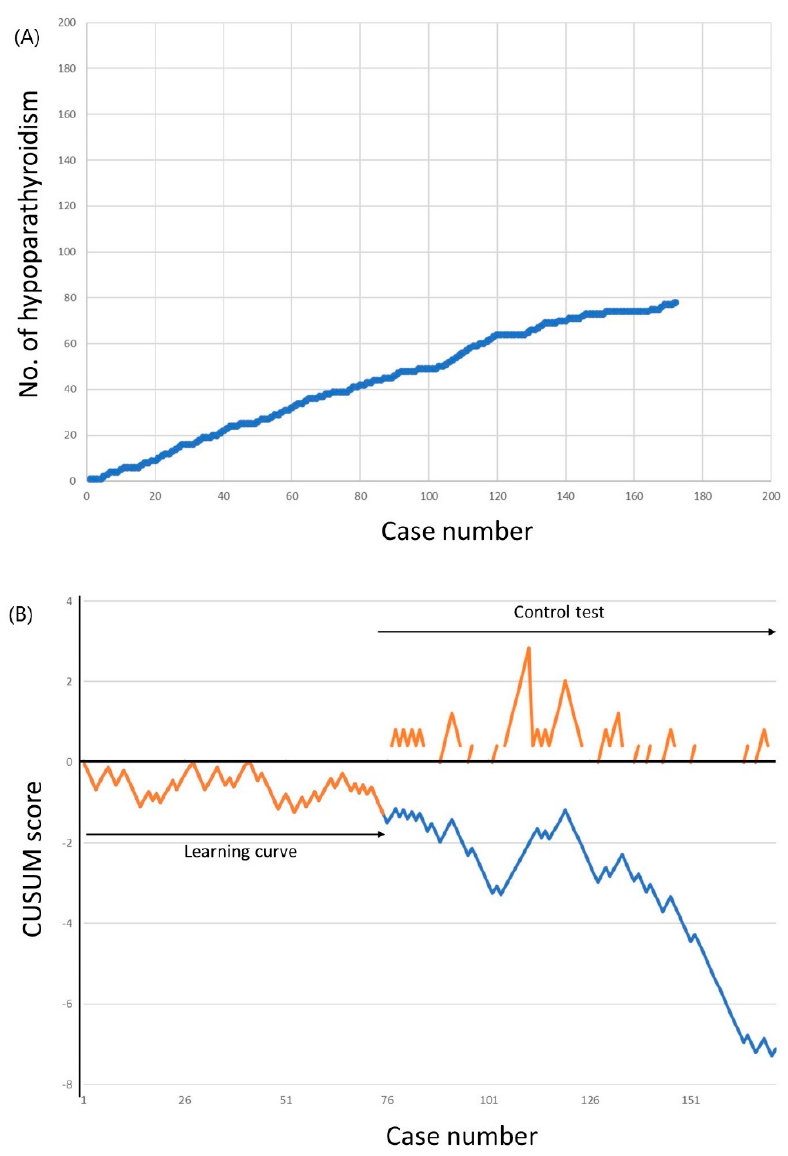
Figure 2. Incidence of transient hypoparathyroidism. ( a ) Cumulative number of transient hypoparathyroidism. ( b ) Cumulative summation test of the hypoparathyroidism incidence for learning curve (LC-CUSUM) and standard cumulative summation (CUSUM) test. The dotted line represents the LC-CUSUM as if it had been continued after the 75th case.